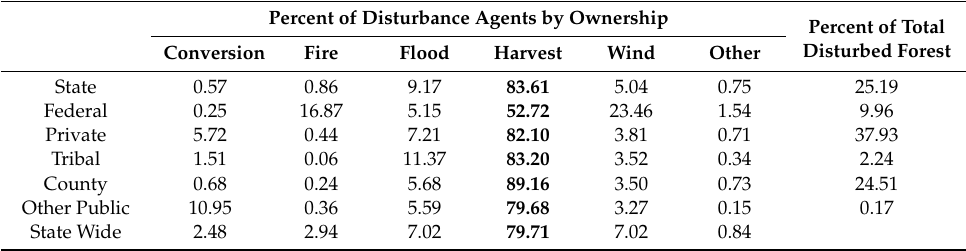
Table 5. Percent of area by agent classes within Minnesota land ownership categories. Numbers in bold identifies the most prevalent disturbance agent for each ownership category.